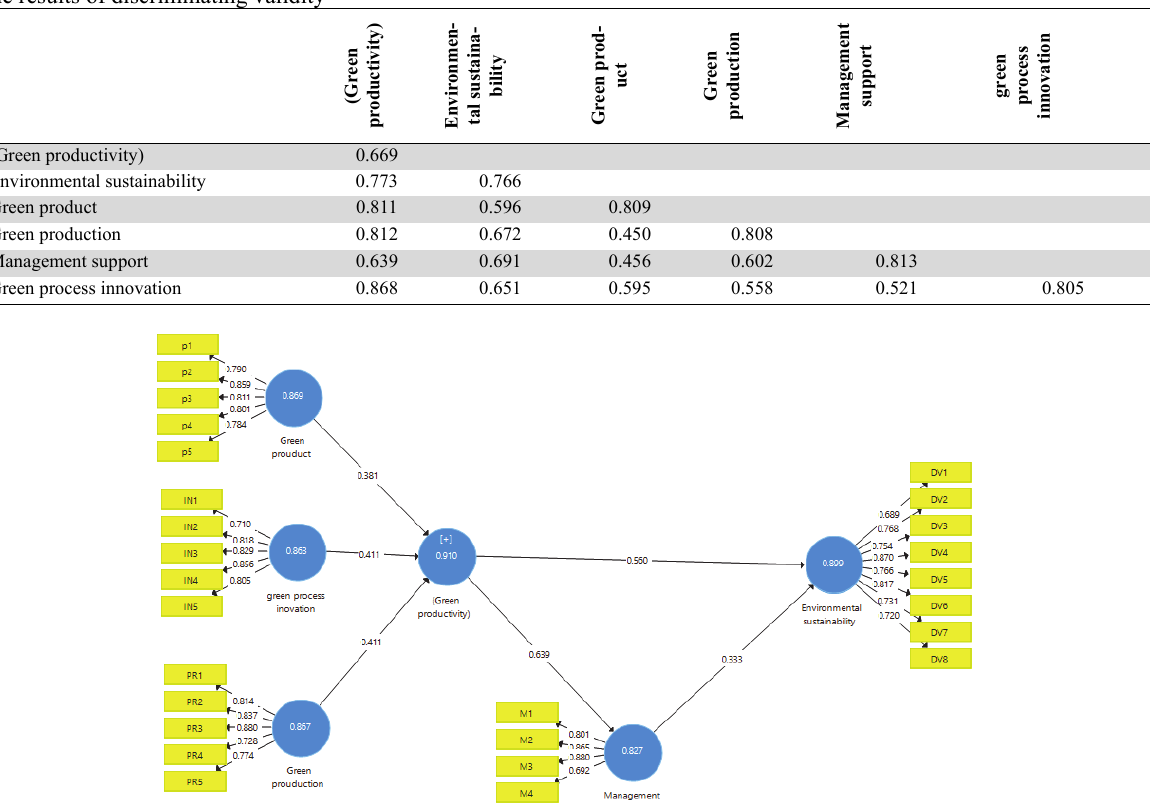
Fig. 3. Model of structured loading and path coefficients discriminate validity for the trimmed model